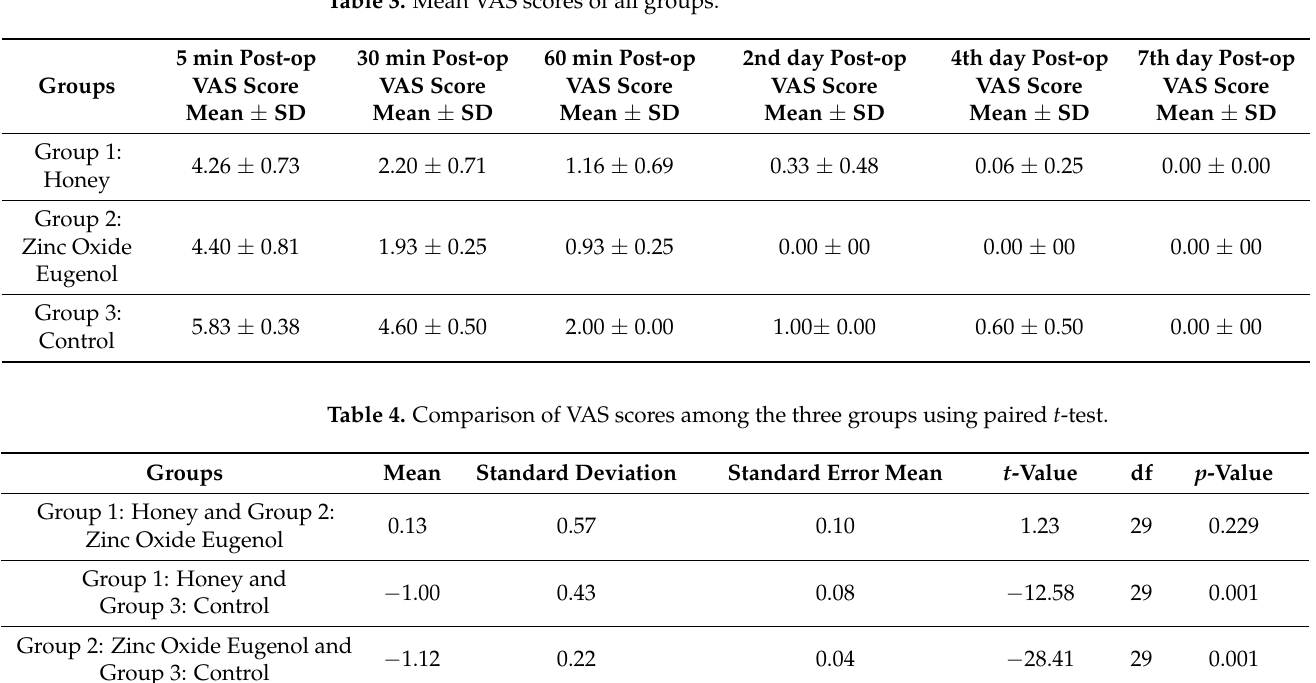
Table 3. Mean VAS scores of all groups.